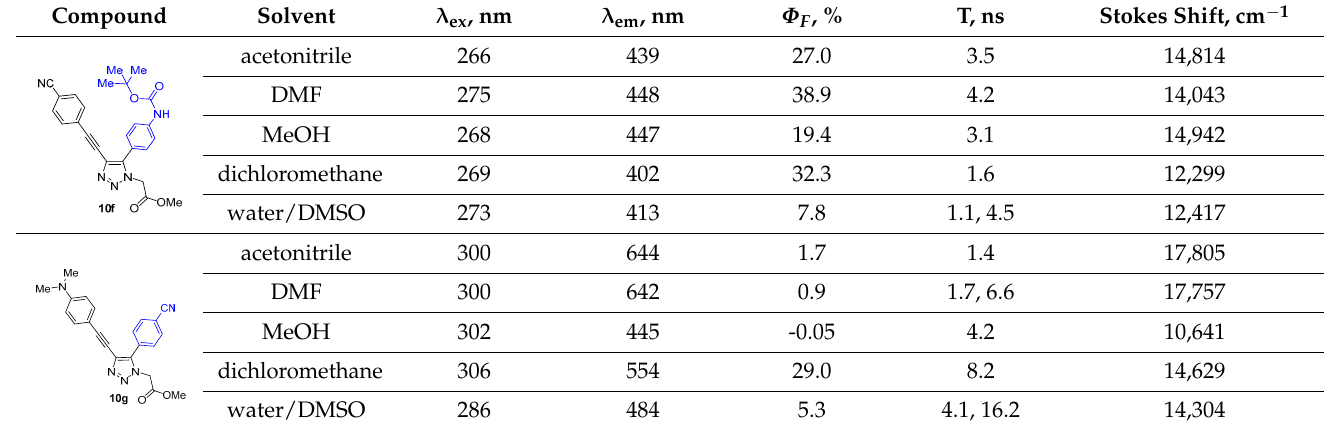
Table 2. Photophysical parameters 10f and 10g in various